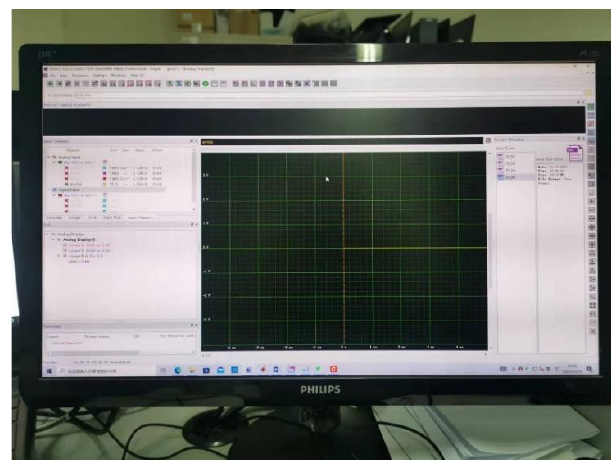
Figure 6. Working interface of upper computer acquisition software.